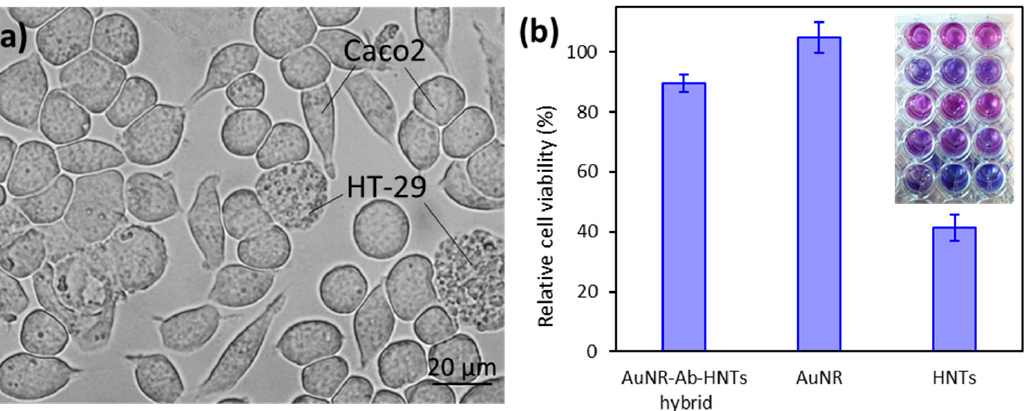
Figure 3. ( a ) Light microscope image of a co-culture of Caco-2 and HT29 cell lines used for cytotoxicity studies. ( b ) Relative viability of the co-culture cells following the exposure of 24 h to AuNR-Ab-HNTs hybrid (1500 µ g mL − 1 functionalized with 20 µ g mL − 1 gold), free AuNR (20 µ g mL − 1 ), and pristine HNTs (1500 µ g mL − 1 ), as measured using the alamarBlue ® cell viability assay. The viability results are normalized to a co-culture grown in growth media only. Inset showing the relevant section of the 96-well used for the assay with the following samples (top to bottom): cells with only growth medium, pristine HNTs, AuNR, AuNR-Ab-HNTs hybrid, and blank (no cells).